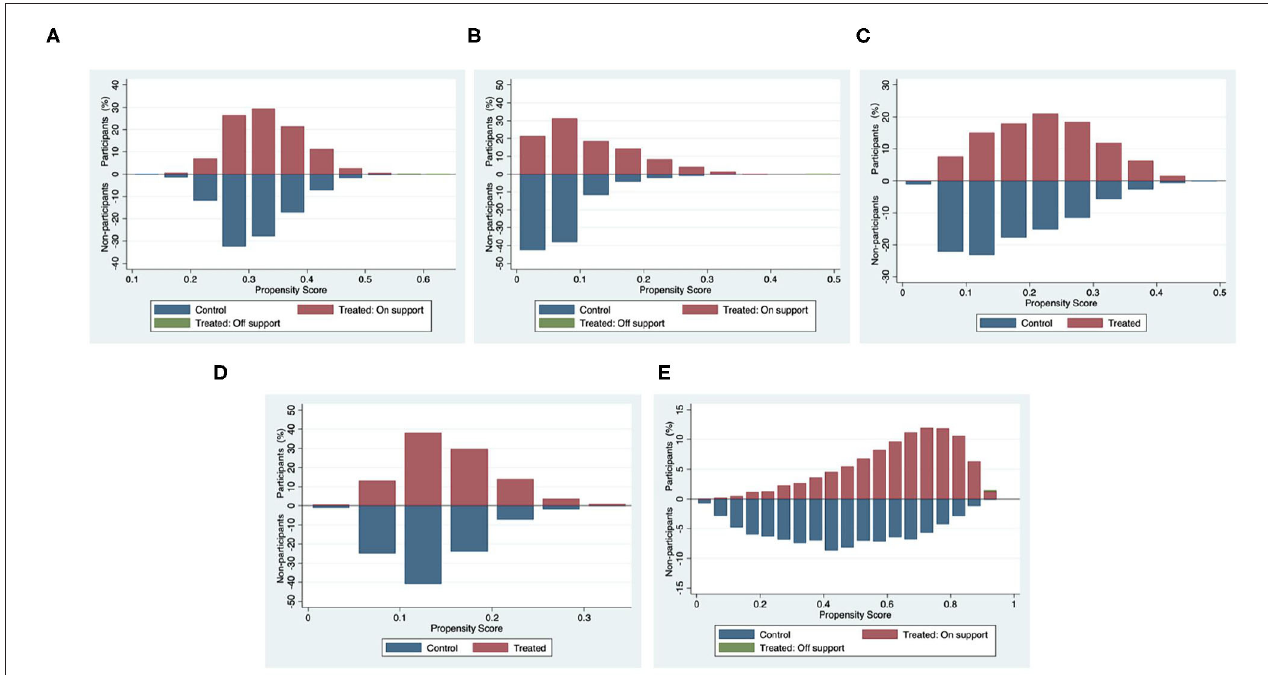
FIGURE 2 | Common value range of propensity scores of participating in five types of social activities. The graphs show percentage shares of participants and non-participants in two states: the treatment group and the control group (the shares for each group add to 100%). The propensity scores of participating in each type of social activity are measured on the horizontal axis (the value range is in [0, 1]). (A) Friend-making activities. (B) Exercise activities. (C) Recreational activities. (D) Helping activities. (E) Economic